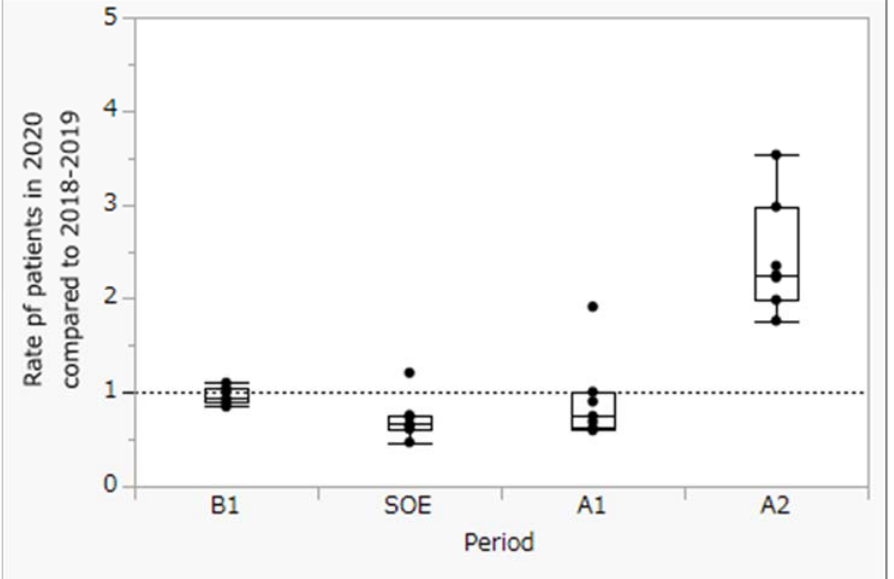
Figure 3. Rate of patients from Tokyo in 2020 compared to 2018–2019 at each time period for calendar week. p < 0.05 (Tukey’s honestly significant difference test).